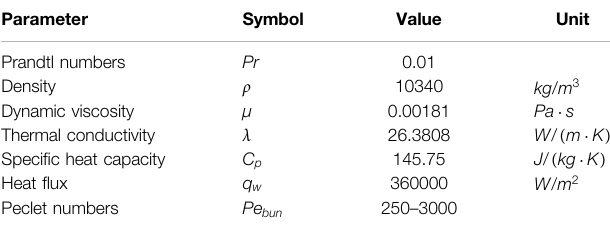
TABLE 2 | Flow parameters of LBE.